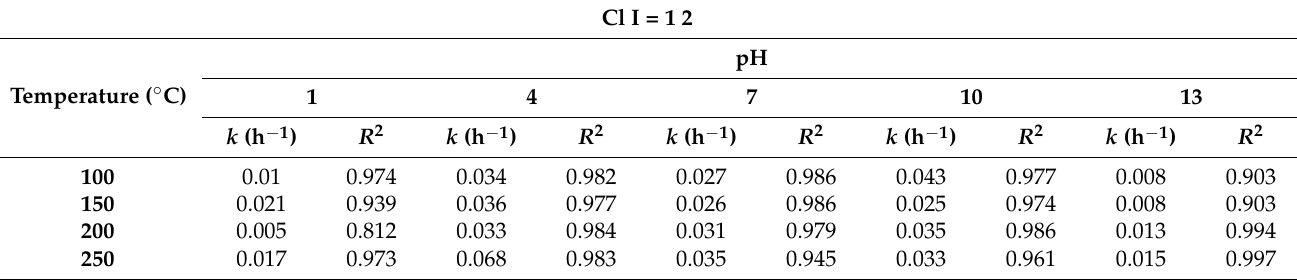
Figure 9. Photodegradation of CV with the irradiation time on various BiOmCln/BiOpIq photocatalysts prepared under a KCl:KI molar ratio of 1:2, a pH of 1–13, and a hydrothermal temperature of 250 °C. Table 2. Rate constants for the pseudo-first-order degradation of CV on the prepared BiO m Cl n /BiO p I q photocatalysts under visible–light irradiation.